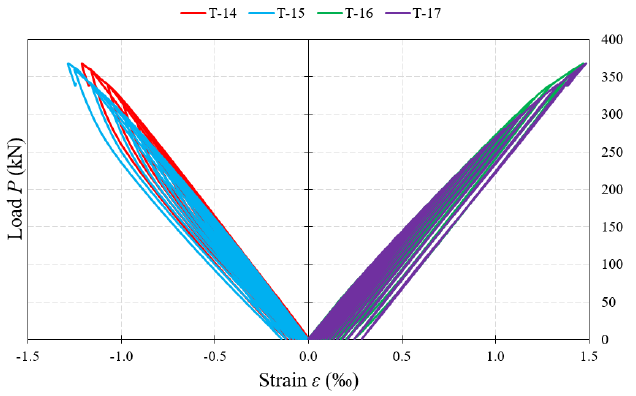
Figure 22. Load–strain relationship in the measurement points located on the upper belt (T-14, T-15) and the lower belt (T-16, T-17).